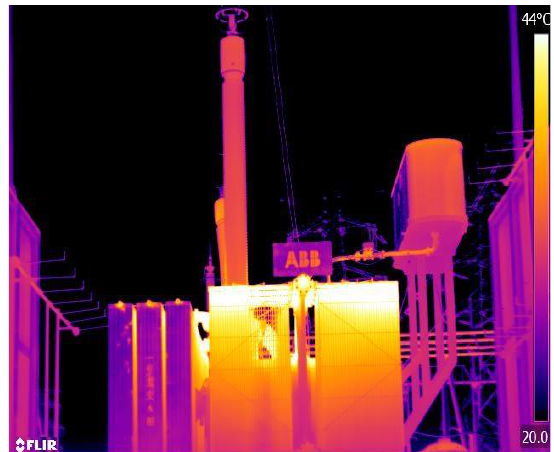
Figure 2. Infrared thermal image of a power transformer in the substation.